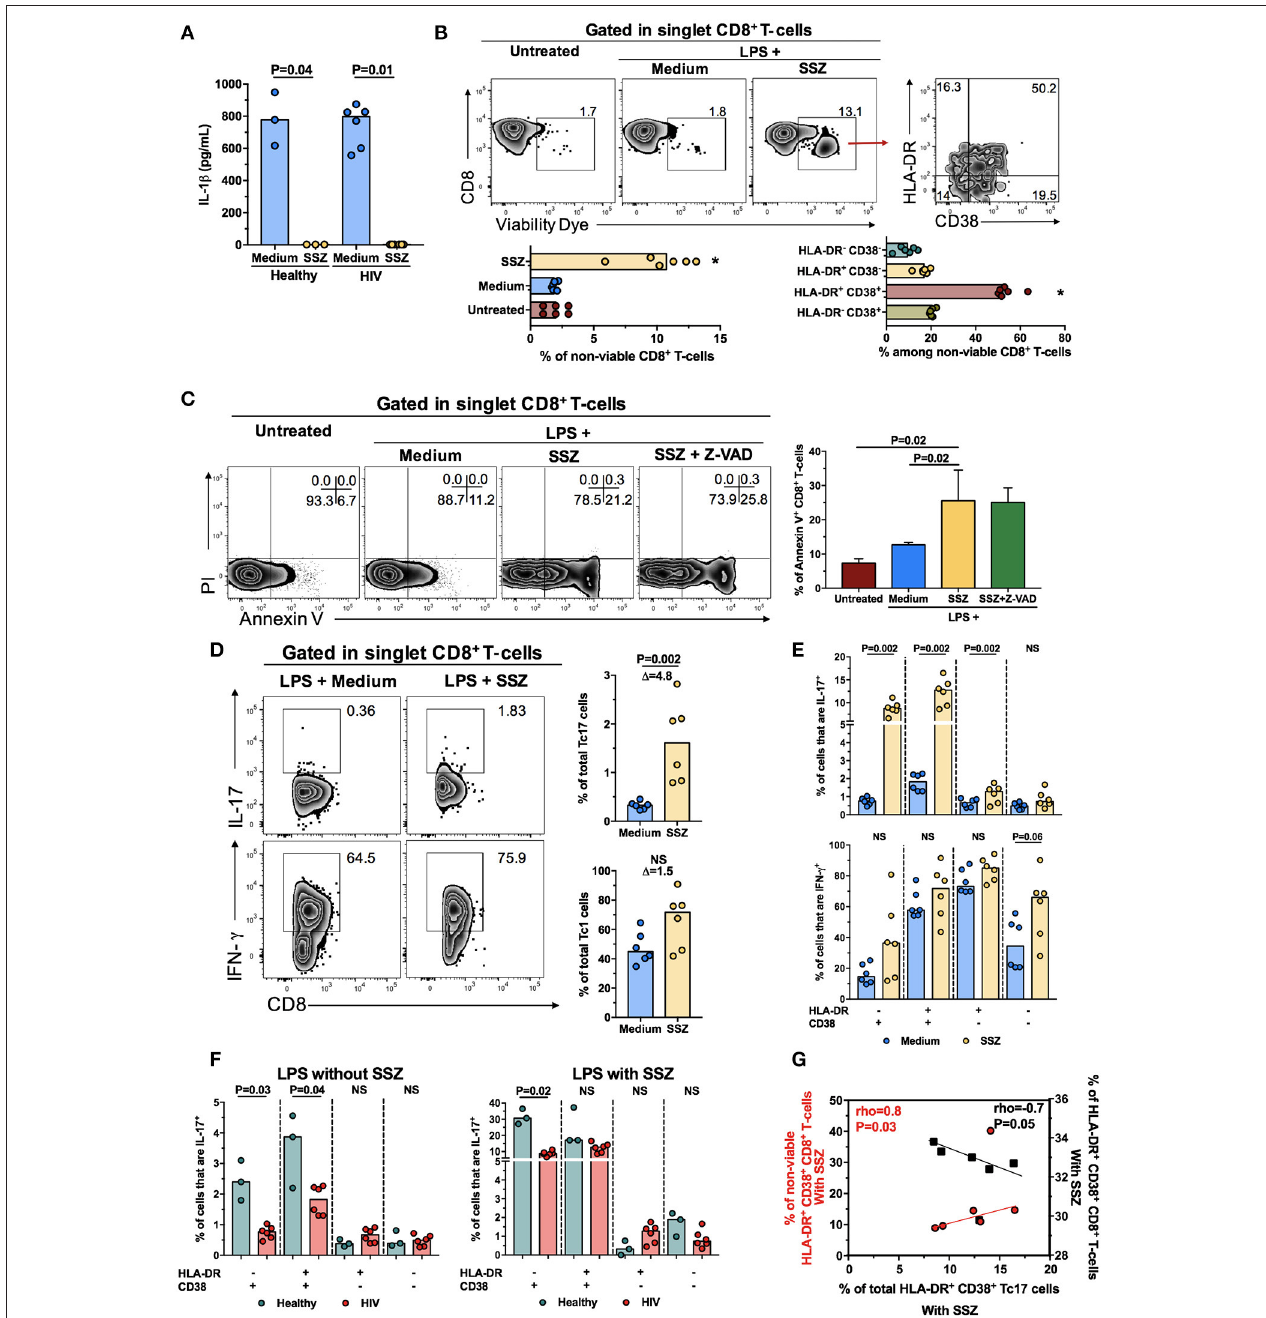
FIGURE 5 | Sulfasalazine increases the frequency of total HLA-DR + CD38 + Tc17 cells from PLWH. (A) Levels of IL-1 β in culture supernatant from PBMC from healthy or PLWH treated with LPS in the presence of medium or sulfasalazine (SSZ). The P -value of the Wilcoxon test is shown. (B) Gating strategy for the detection of non-viable CD8 + T-cells in untreated and LPS-treated cells, the latter in the presence of medium or SSZ. The proportion of HLA-DR- and CD38-expressing non-viable CD8 + T-cells after SSZ treatment is shown in the right. Zebra plots from a representative subject living with HIV are shown. The summary of the frequency of total and HLA-DR- and CD38-expressing non-viable CD8 + T-cells in the respective conditions are shown. n = 3 healthy individuals and 6 PLWH. * P < 0.03 vs. all the other groups. (C) Gating strategy for the detection of Annexin V and/or Propidium Iodide (PI)-positive CD8 + T-cells in untreated and LPS-treated cells, the latter in the presence of medium, SSZ and SSZ plus Z-VAD. Zebra plots from a representative subject living with HIV are shown. The summary of the frequency of Annexin V + CD8 + T-cells in the respective conditions is shown on the right. n = 4 PLWH. In (B,C) the P -value of the Kruskal-Wallis and Dunn’s post-hoc test are shown. (D) Frequency of total Tc17 and Tc1 cells from a subject living with HIV after LPS treatment in the presence of medium or SSZ. The numbers in the zebra plots indicate the